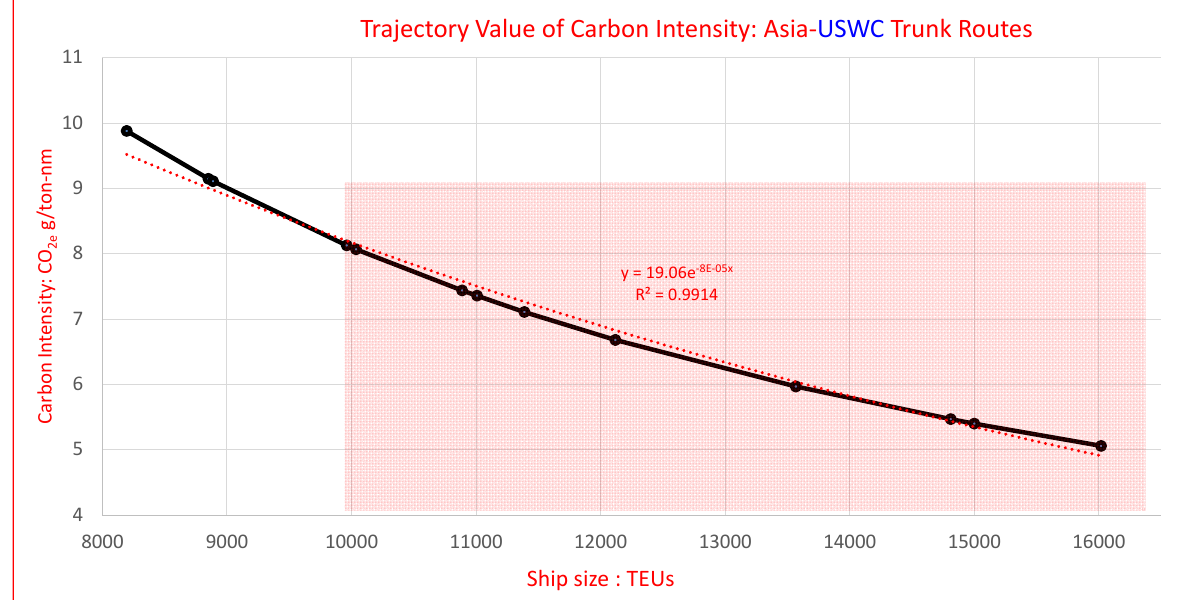
Figure 3. The Carbon Intensity against Ship Size of Route B.